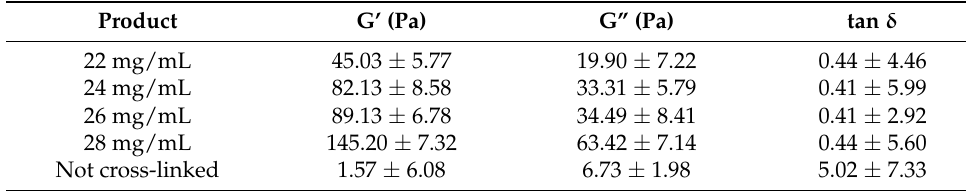
Table 5. Rheological results obtained by the characterization of the five HA hydrogel dermal fillers at 37 °C and at a frequency value of 1 Hz. Data are represented as averages and relative standard deviations percentage (RSD %).